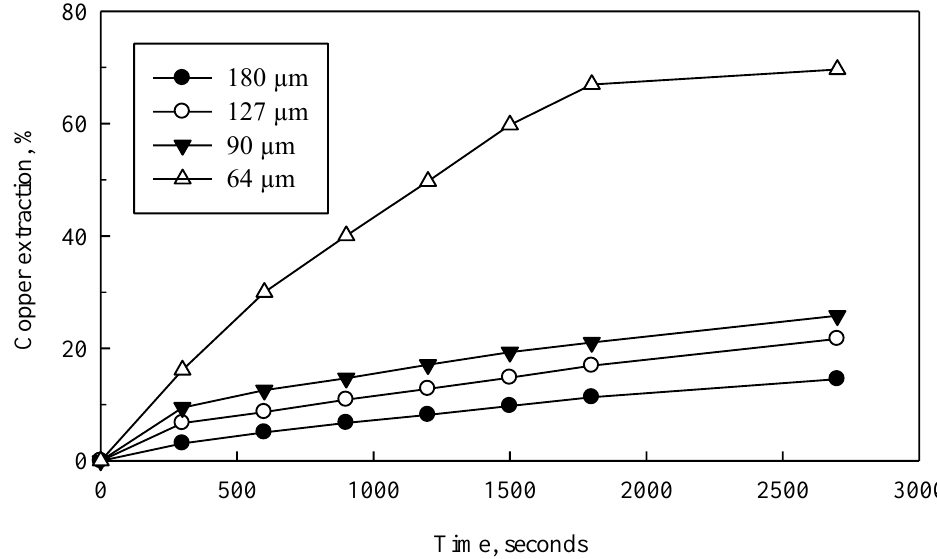
Figure 10. Evaluation of particle size in copper extraction rate. Working conditions: pH = 10.5, [NH 4 OH] = 0.7 mol/dm 3 , T = 298 K, Agitation = 500 rpm, ratio = 1000/1.